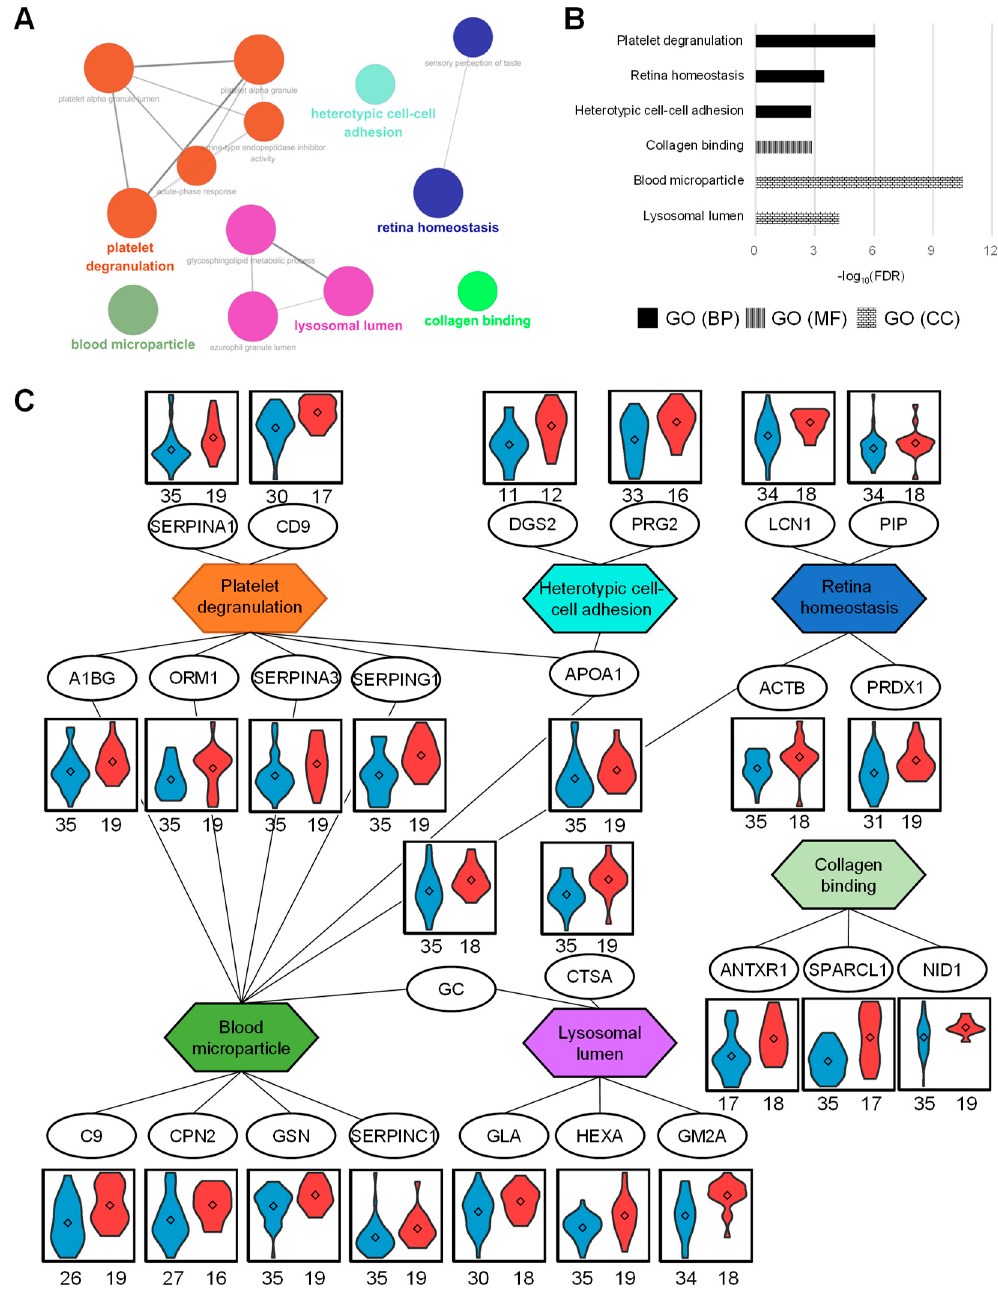
Figure 4. Up-regulated proteome in poor-prognostic group (PPG) and GO analysis. ( A ) Functional GO network displaying grouping of GO terms enriched in PPG up-regulated proteins. ( B ) Enriched GO terms in biological process, molecular function, and cellular component. ( C ) The network between GO terms and their contained proteins represents the relationship between GO terms via the proteins. The abundance of proteins represents the violin plots in two sample groups. The numbers listed below represent the measured numbers for each group.